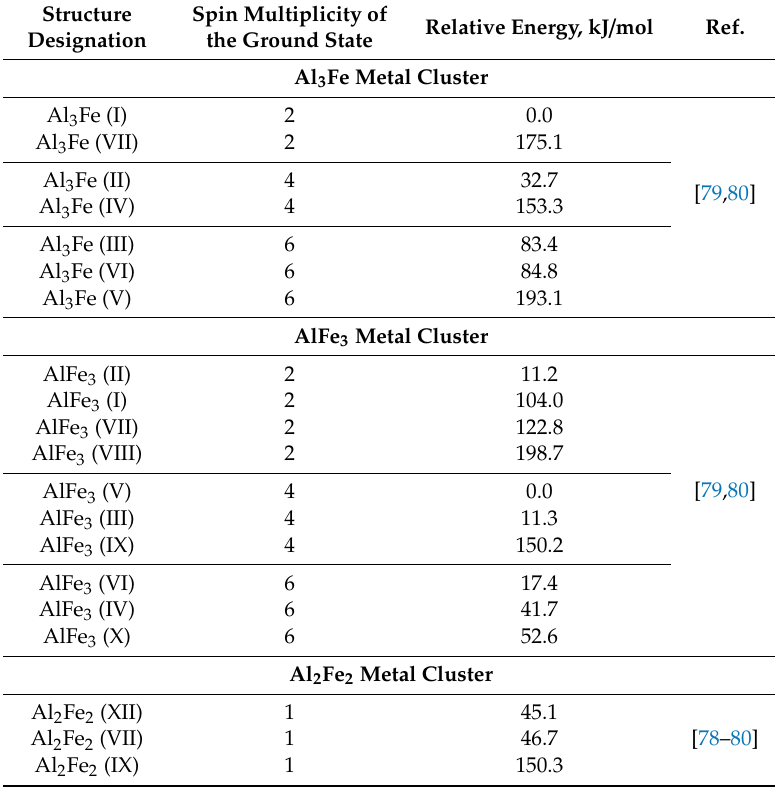
Figure 2. The image of molecular structure of most stable Al 2 Fe 2 isomer [79]. Table 1. Relative energies and spin multiplicities of the ground states of various isomers of metal clusters Al 3 Fe, AlFe 3 and Al 2 Fe 2 . Roman numerals in the table are the designations of these metal clusters presented in the original works.